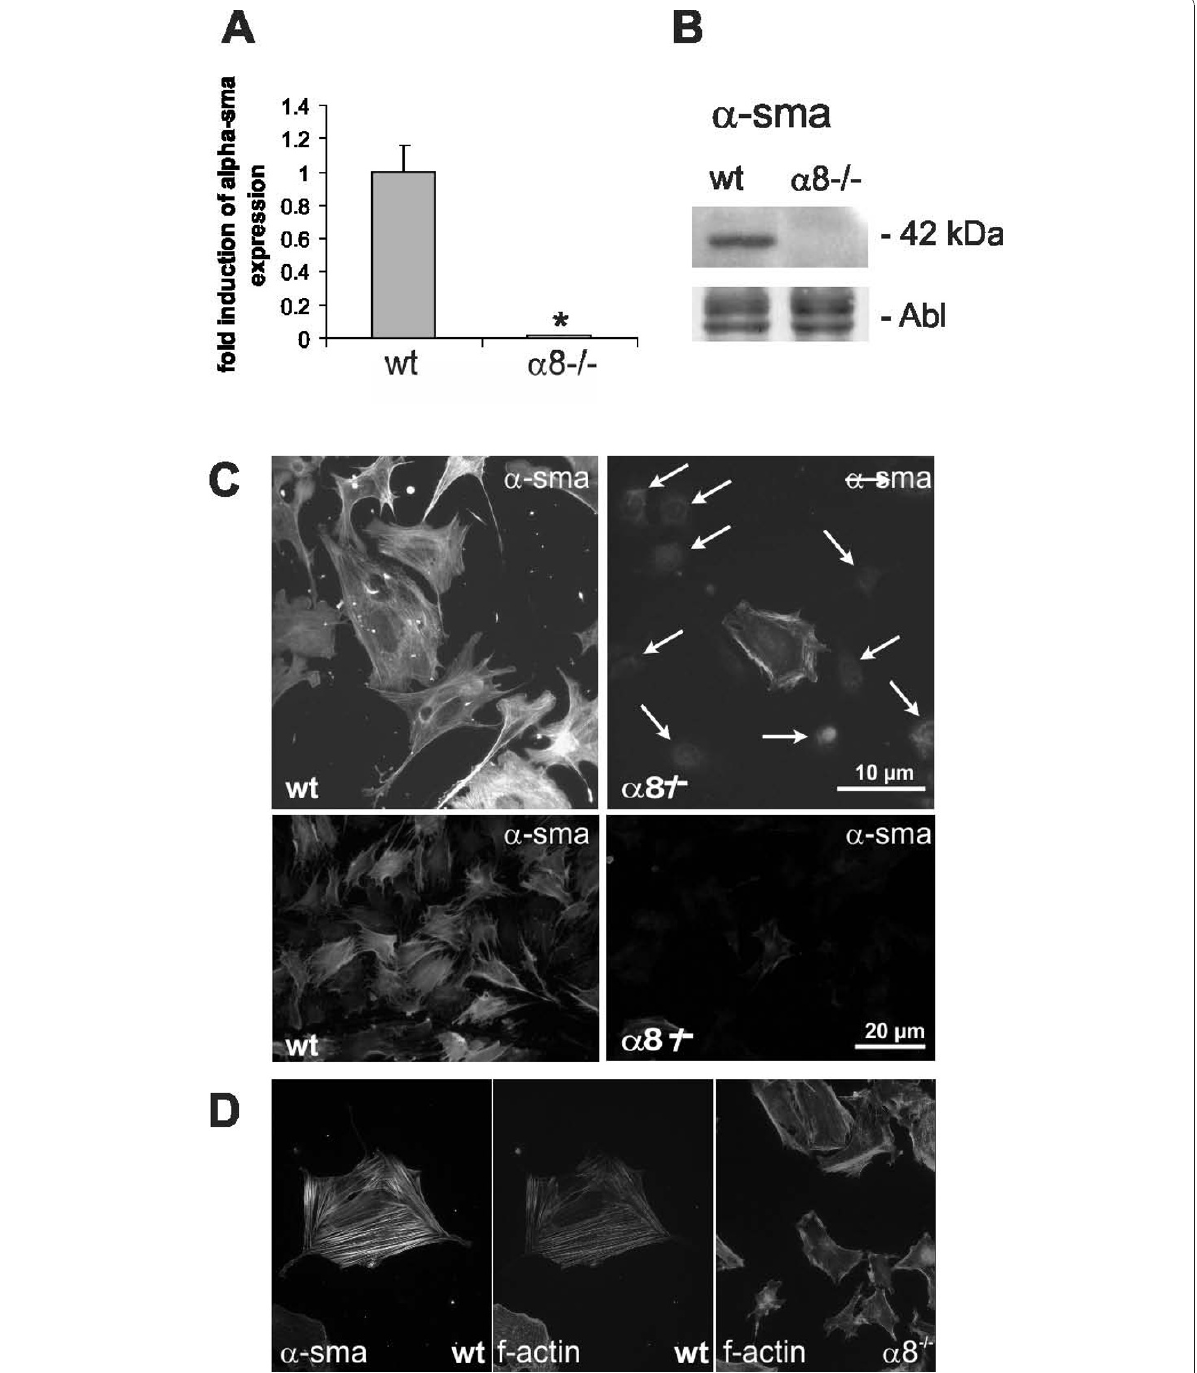
Figure 3 Comparison of a -smooth muscle actin expression in wild type (wt) and a 8 integrin-deficient ( a 8-/-) mesangial cells . mRNA expression analysis by real-time RT-PCR analysis (A), representative Western blot analysis with amido black (Abl) staining as loading control (B) and immunofluorescent detection of a -smooth muscle actin (C). Arrows indicate cell nuclei of cells negative for a -smooth muscle actin. D: Doublestaining of wild type mesangial cells for a -smooth muscle actin (left) and f-actin (middle panel). Detection of f-actin in a 8-/- mesangial cells (right). Results are representative for at least 3 similar experiments. Data are means ± sd. * p < 0.05 vs.